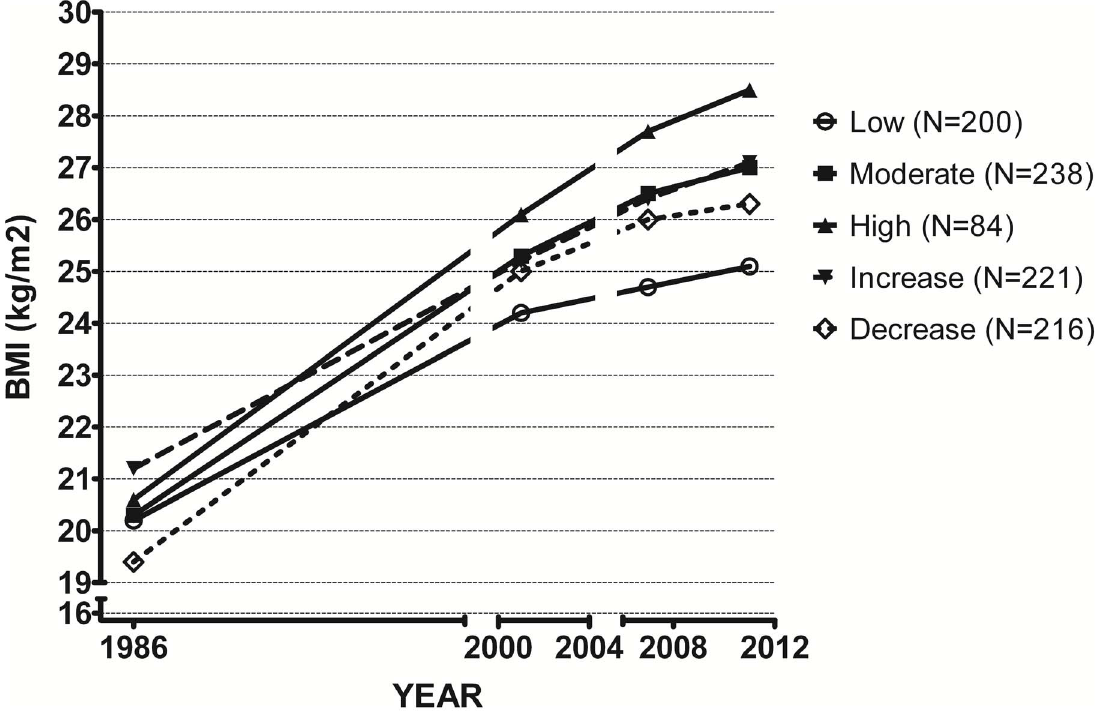
Figure 3. BMI change during 10 years of follow-up depending on daily TV time, and its stability or change. In addition, the BMI from 1986 (14 years prior) is shown.